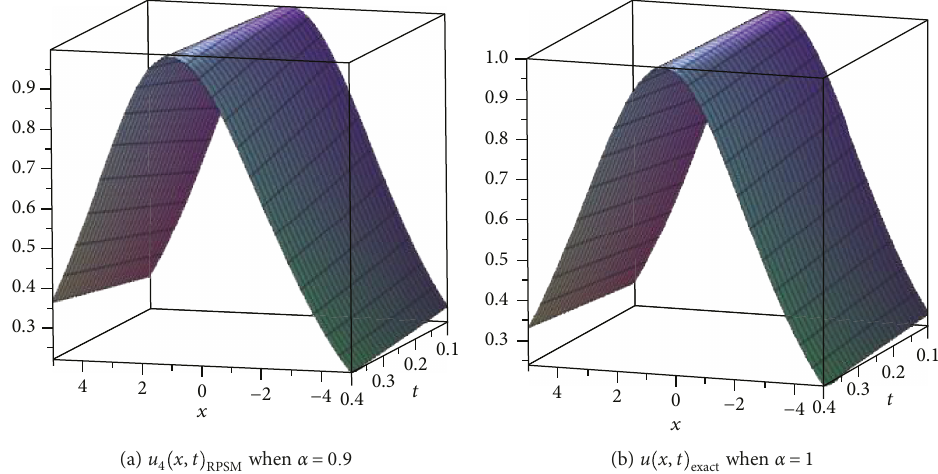
Figure 1: 3D graphics of the exact and approximate solutions.